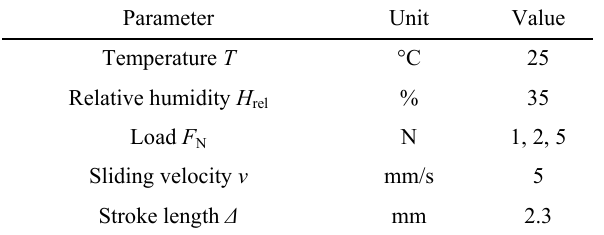
Table 4 Parameters of the tribological